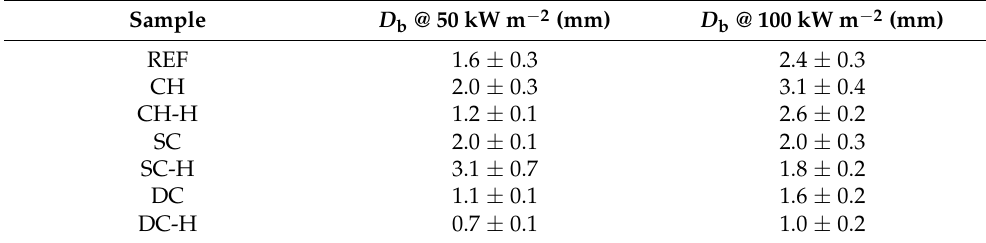
Table 3. Bubble departure diameters at 50 kW m − 2 and 100 kW m − 2 including standard